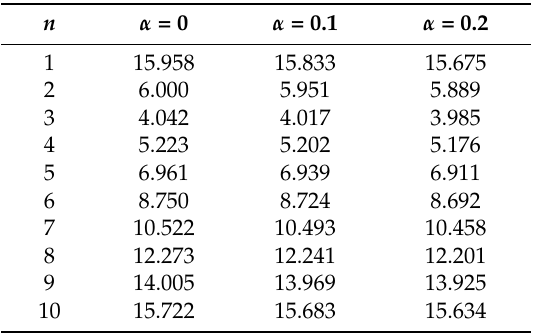
Table 7. Variation of the natural frequency ω (GHz) against circumferential wave number n for different porosity volume fractions α of FGPM-I nanoshell (C-SS).